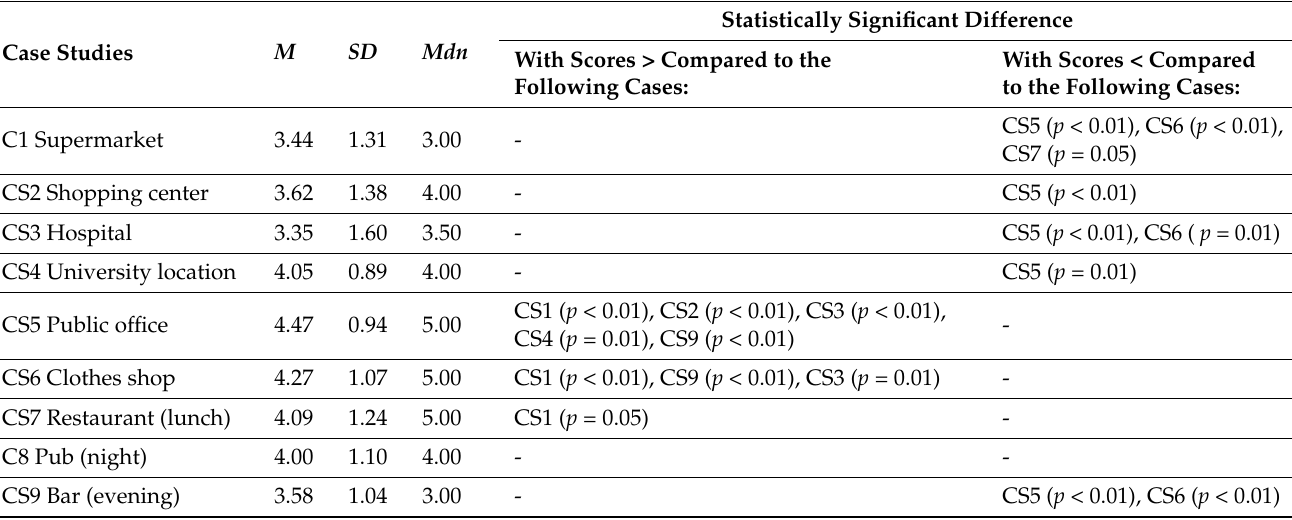
Table A15. Table shows the statistically significant differences ( p (BH)) that emerged from the comparison of item 12 in the different case studies (CS1–CS9). In the table is also reported the mean ( M ), the standard deviation ( SD ) and the median ( Mdn ). Own